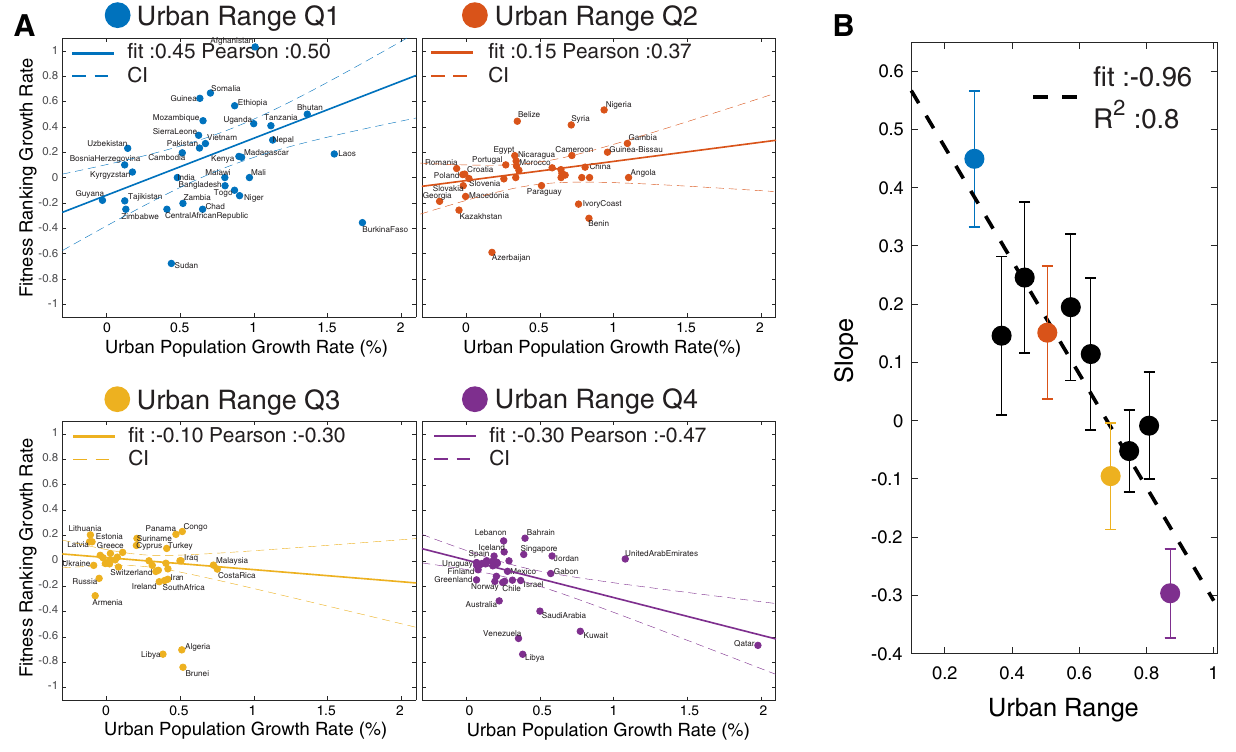
Figure 3. ( A ) The Fitness Ranking Growth Rate versus Urbanization Growth Rate. The effect of urbanization growth on the transformation of the economic systems (or vice-versa) is more relevant in low urbanize countries. The dashed lines represent the 95% Confidence Interval (CI) of the linear regression. ( B ) Slope coefficient of a sliding window across 25% of the countries (corresponding to 36 countries) of its fitness ranking growth rate versus urban population growth rate. The error bar corresponds to the fit’s 95% confidence interval. The colors follow the Urban Range